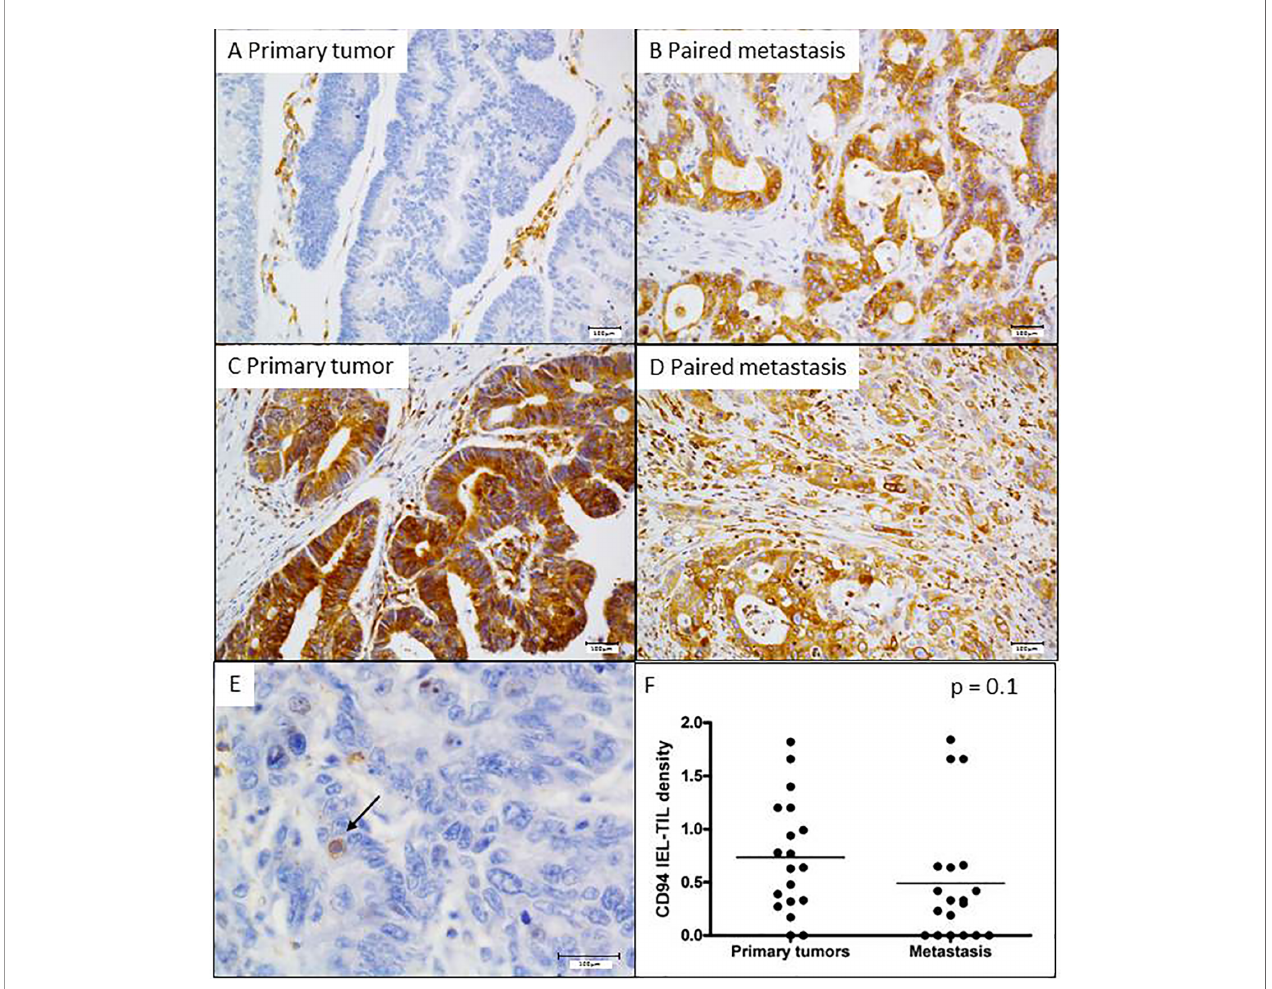
FIGURE 4 | Expression pro fi le of HLA-E in primary and metastatic tumors, and its association with intraepithelial CD94 + lymphocytes. Two representative cases of mCRC with distinct HLA-E overexpression pro fi le. (A, B) A discordant pro fi le of HLA-E/ b 2m overexpression between primary tumor (negative) and its matched metastasis (positive) and (C, D) a concordant case featuring HLA-E overexpression both in primary tumor and its paired metastasis. (E) CD94 + intraepithelial lymphocytes. (F) The density of CD94 + intraepithelial lymphocytes is quite similar between primary tumors and metastases (p = 0.1 Mann Whitney test).